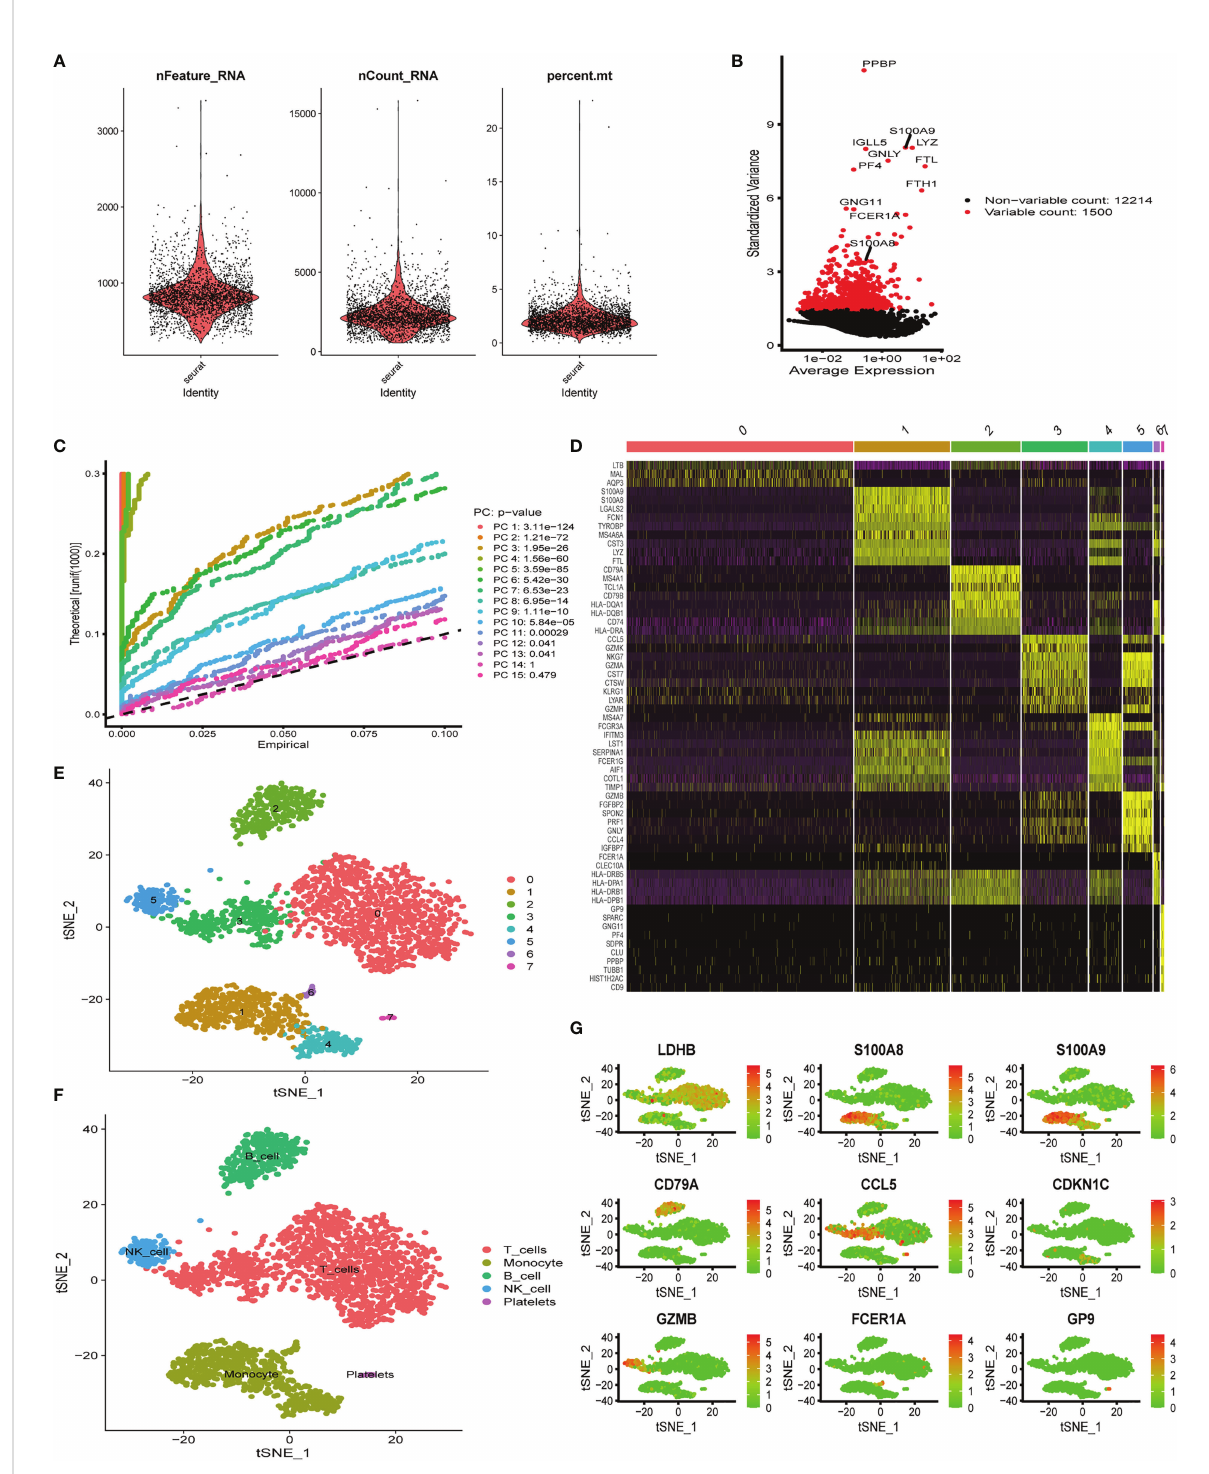
FIGURE 5 Single-cell quality control and dimension reduction clustering at our center. (A) The percentage of mitochondrial genes and erythrocyte genes was limited to ensure the reliability of cell samples; (B) 1,500 highly variable genes are shown in red, with the top 10 highlighted. (C) Principal component analysis (PCA) of the single-cell expression pro fi les. (D) Heatmap of expression patterns of cluster-enriched genes. (E, F) Dimensionality reduction and cluster analysis. The cells in the valve could be divided into eight clusters, which could be approximately summarized as T cells, monocytes, B cells, NK cells, and platelets. (G) Expression of marker genes in the main cell clusters based on the tSNE